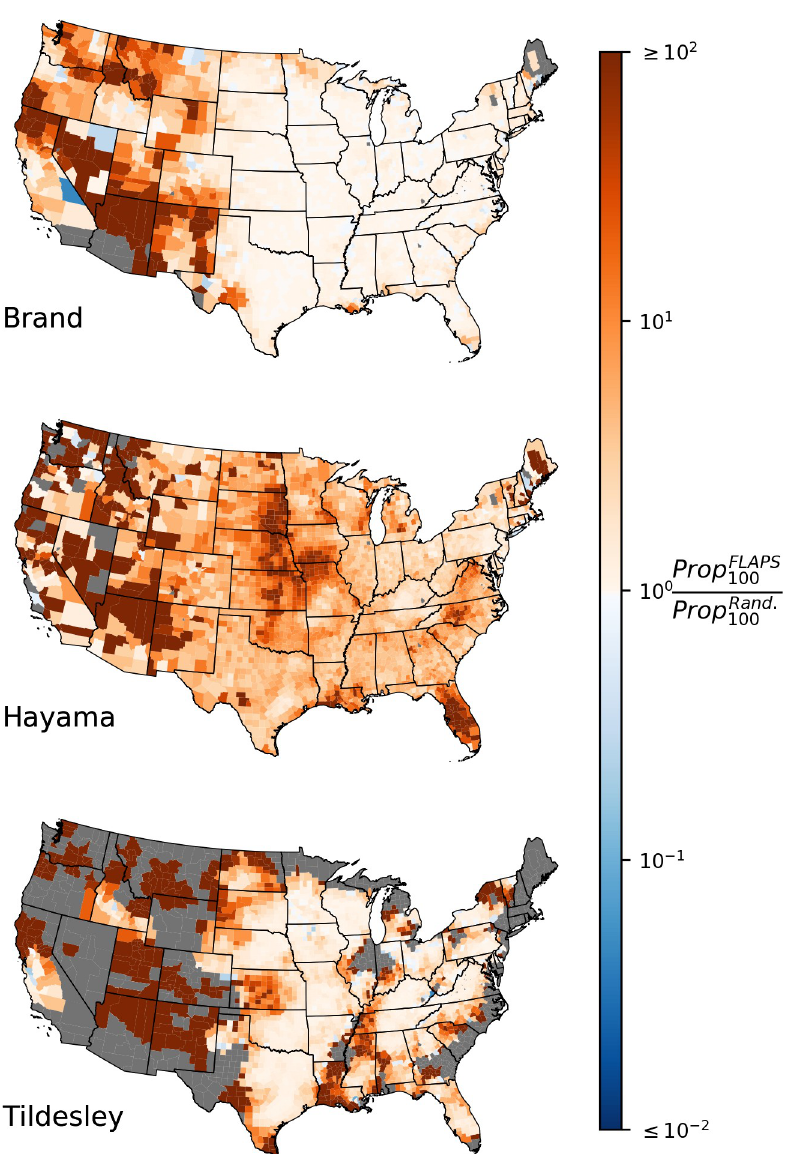
Fig 5. Differences in probability of large outbreaks. Transmissibility x5. County-level proportional change in number of replicates that reached 100 infected premises when using FLAPS compared to randomized configurations. Grey indicates counties where no replicate reached 100 infected in either FLAPS simulations or randomized simulations or both. Results are based on kernel parameterizations with five-fold increase in transmissibility.